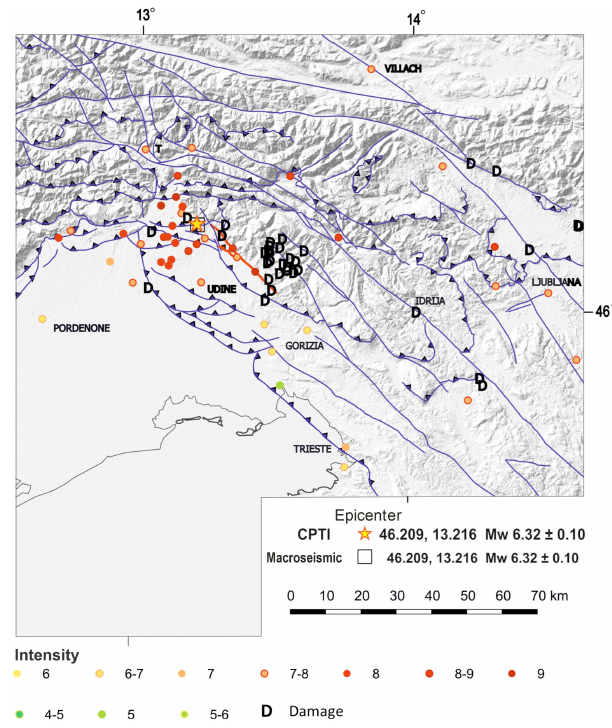
Figure 8. Damage distribution of the 1511 earthquake from CPTI (Rovida et al., 2016; Locati et al., 2016); red lines, BFCF-CVT sys-